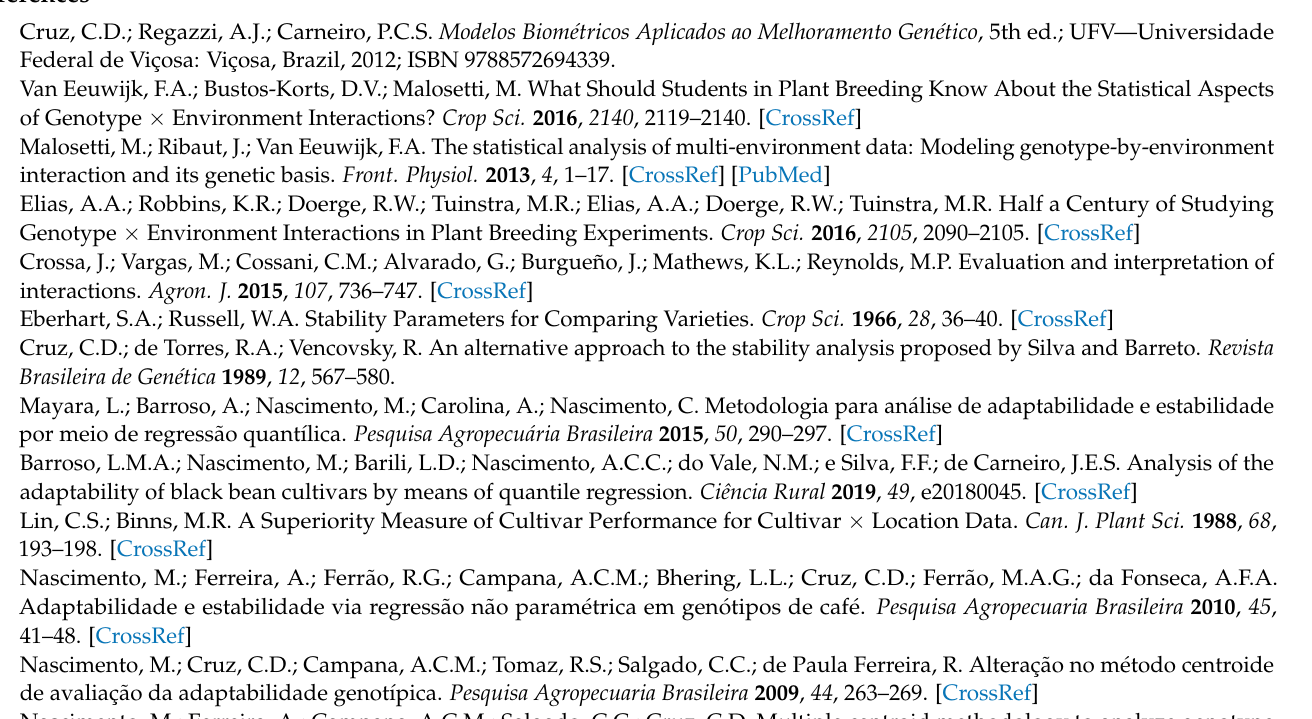
Figure S3: Estimated lines by Eberhart and Russell (1966), non-parametric and quantile regressions ( τ = 0.50) to the genotype BRS 286, considering the experimental data, Figure S4: Estimated lines by Eberhart and Russell (1966), non-parametric and quantile regressions ( τ = 0.50) to the genotype BRS 368 RF, considering the experimental data., Figure S5: Estimated lines by Eberhart and Russell (1966), non-parametric and quantile regressions ( τ = 0.50) to the genotype TMG 41 WS, considering the synthetic data, Figure S6: Estimated lines by Eberhart and Russell (1966), non-parametric and quantile regressions ( τ = 0.50) to the genotype NUOPAL, considering the synthetic data, Figure S7: Estimated lines by Eberhart and Russell (1966), non-parametric and quantile regressions ( τ = 0.50) to the geno- type BRS 369 RF, considering the synthetic data, Table S1: Absolute studentized residuals, leverage and environmental index considering the experimental data, Table S2: Difference in adaptability parameter estimated for each genotype with and without the environment (DFBETA) considering the experimental data, Table S3: Cook’s distance for the experimental data, Table S4: Absolute studentized residuals, leverage and environmental index considering the synthetic data, Table S5: Difference in adaptability parameter estimate for each genotype with and without the environment (DFBETA) considering the synthetic data, Table S6: Cook’s distance for the synthetic